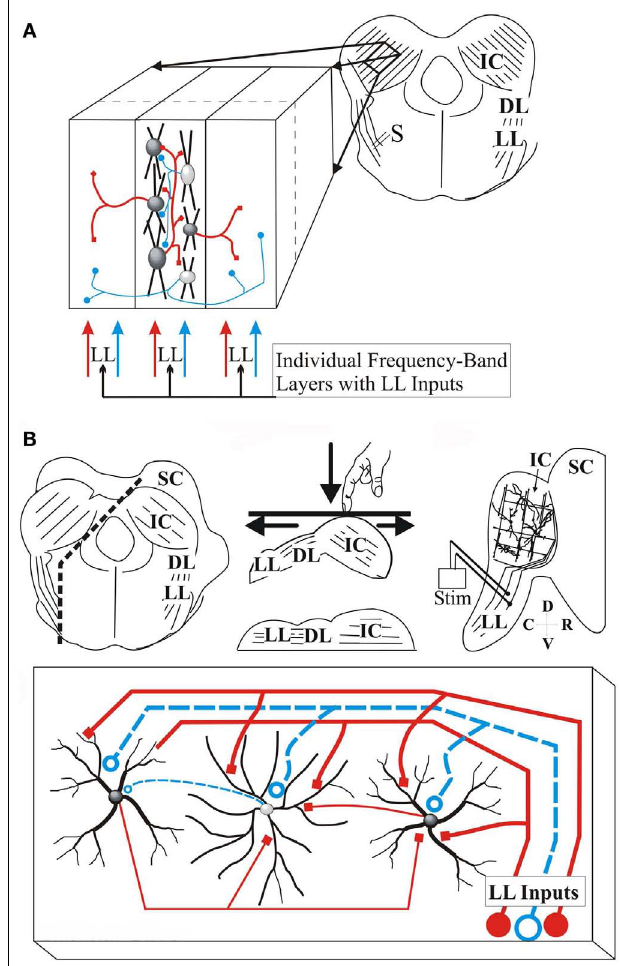
FIGURE 1 |Transverse and laminar slice planes of the IC. (A) Schematic of the transverse IC slice. Right, slice plane with parallel arrangement of laminae; IC, inferior colliculus; LL, lateral lemniscus; DL, dorsal nucleus of the lateral lemniscus; S, Lemniscal stimulating electrode; Left, Expanded region of the slice illustrates laminar and cross-laminar arrangement with lemniscal input; Center section, arrangement of cells within a lamina with intra-laminar connections; Left and right sections, neighboring laminae receive inter-laminar connections; Red, excitatory; blue, inhibitory. (B) Schematic of laminar IC slice plane.Top,Transverse brain slab with additional cuts to generate a laminar slab; Left panel, Direction of the two cuts (dashed lines) made in the transverse brain slab; the lower cut parallel to LL afferents and the upper cut parallel to the laminae; middle panel, orientation of the brain slab on the surface of the vibratome cutting plate. The slab is pushed down so that the bottom surface straightens out, generating a single plane containing LL afferents and the IC. Right panel, the laminar slice; Only one side of the IC is present. SC, superior colliculus; Stim, LL stimulating electrode; Bottom,The laminar slice plane contains LL input fibers synapsing on rows of disk-shaped neurons, and local circuitry; Red, excitatory; blue, inhibitory (Reprinted and adapted with permission from Springer).